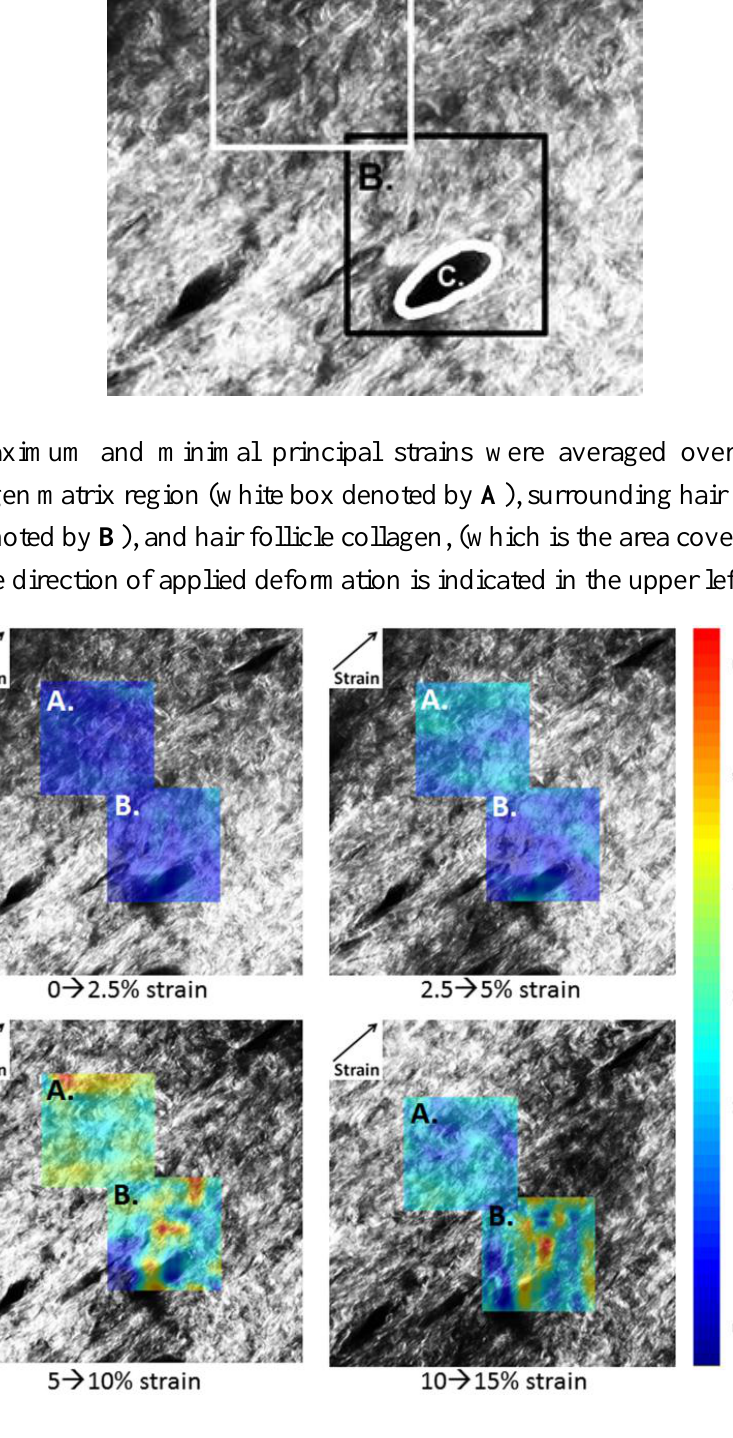
Figure 5. Maximum principal strain maps for matrix region ( A ) and hair follicle region ( B ). Percent strain is given as the difference between images as indicated. Strain direction is indicated in the upper left